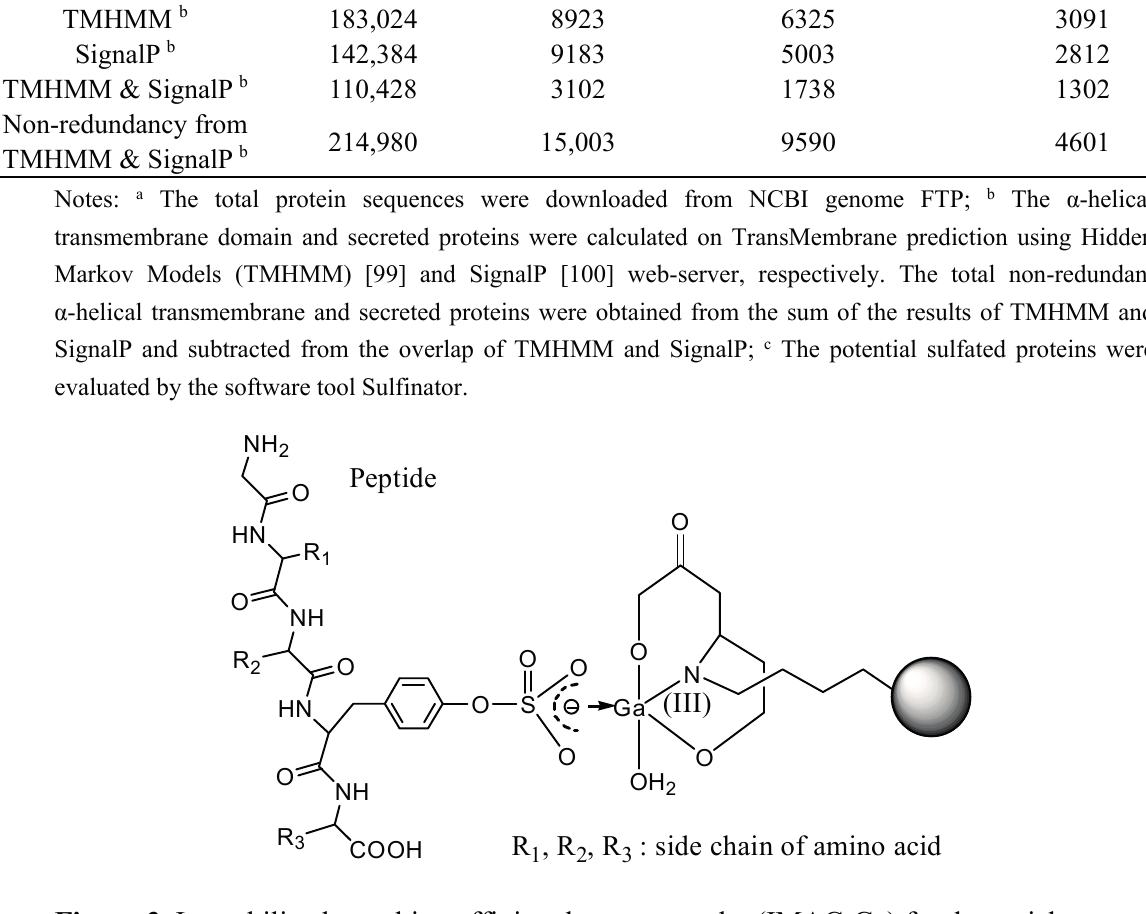
Figure 3. The IMAC-Ga enrichment method also enriches the phosphorylated peptides [101].